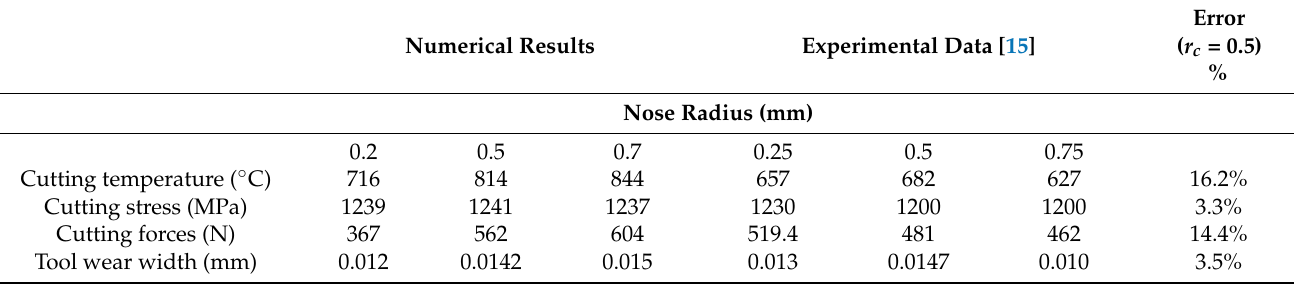
Table 5. Numerical and experimental results comparison for large tool nose